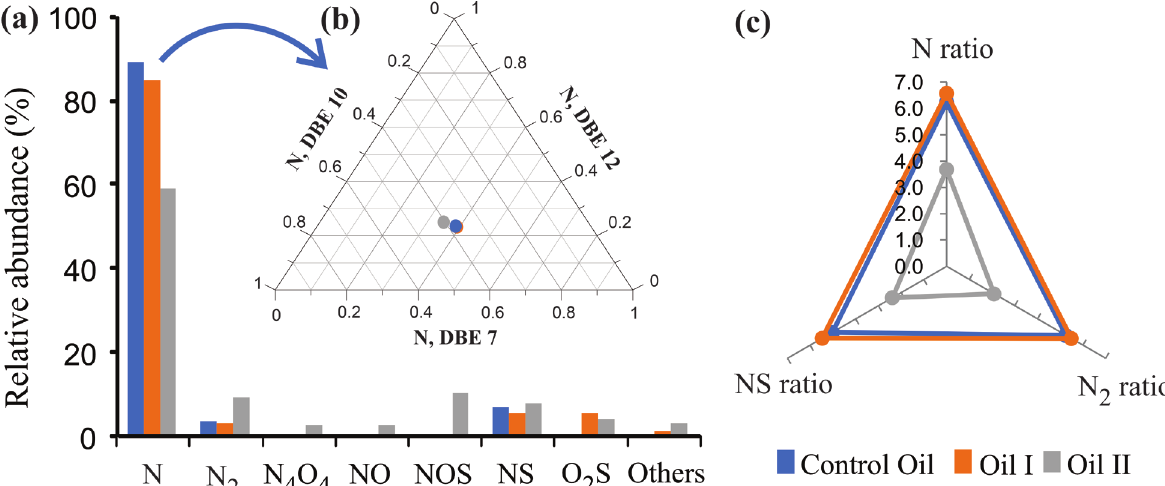
Figure 4. (a) Heteroatom class distributions for Control Oil, Oil I, and Oil II. (b) Ternary diagram used in geochemical studies of maturity assessment illustrating the effect of MEOR (Oil II) on the polar nitrogen compounds of the Control Oil. (c) Star diagram showing the DBE ratios for the N (DBE 4-13/DBE 14-23), N NS (DBE 6-13/DBE 14-21) classes in the Control Oil and the recovered Oils I and